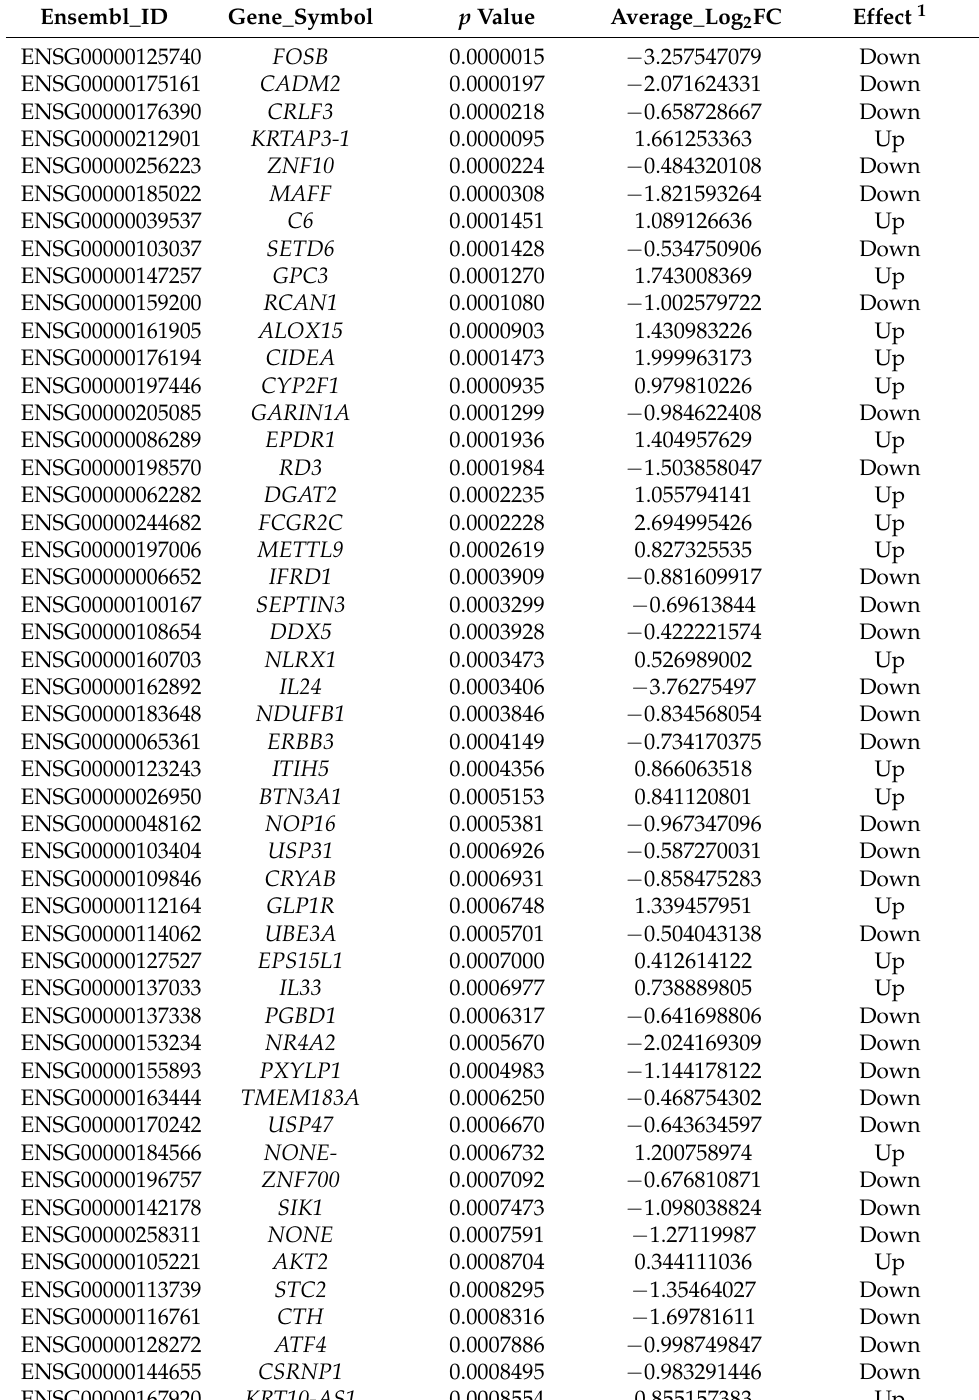
Table 1. Top 50 DEGs identified in the